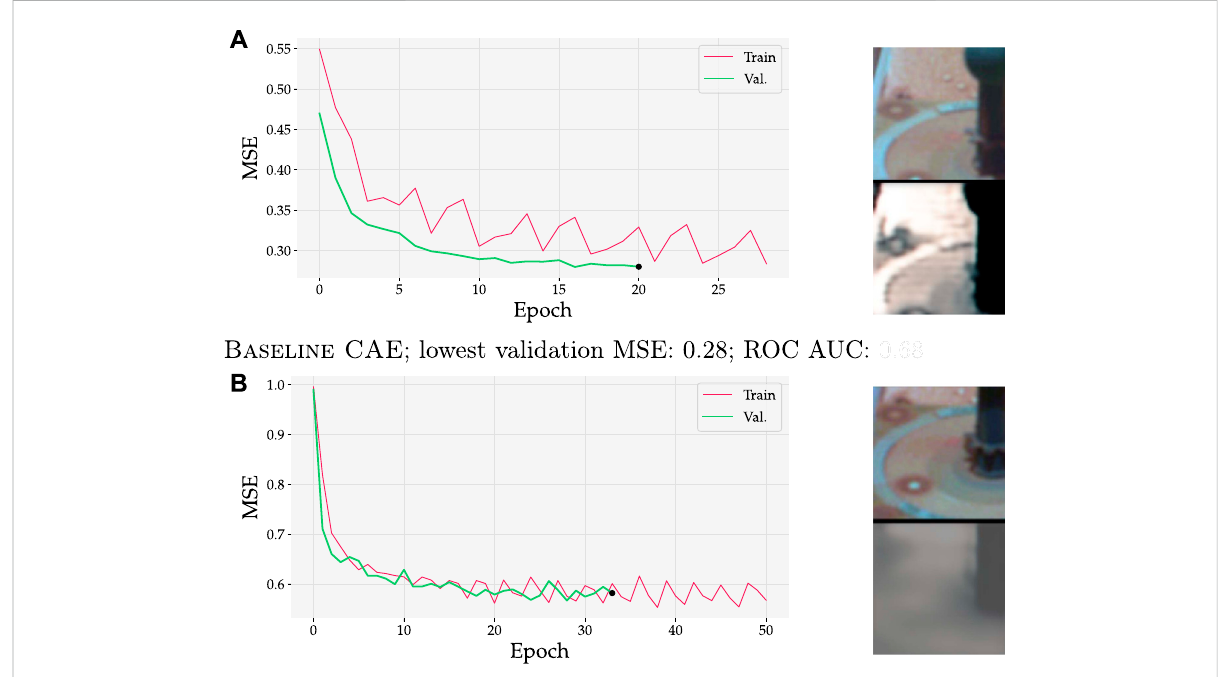
FIGURE 11 Training and validation curves (left) for two models trained on Curiosity Mastcam data. Input and reconstruction samples from the fi nal validation epoch are shown for qualitative comparison. Although MSEs were almost 2× higher for BASELINEVAE , it still achieved a slightly better ROC AUC than BASELINECAE . (A) Baseline CAE; lowest validation MSE = 0.28 achieves an ROC AUC = 0.68. (B) Baseline VAE; lowest validation MSE = 0.58 achieves an ROC AUC =